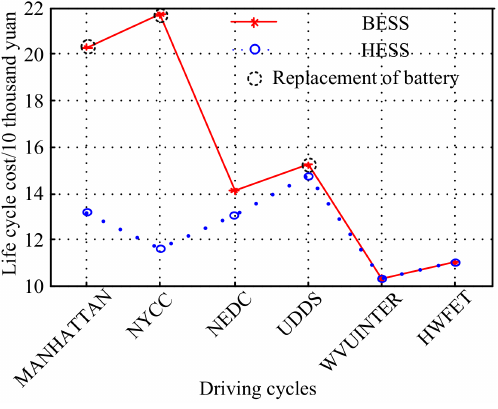
Figure 4. Optimal economic results of hybrid energy storage system (HESS) and battery energy store system (BESS).